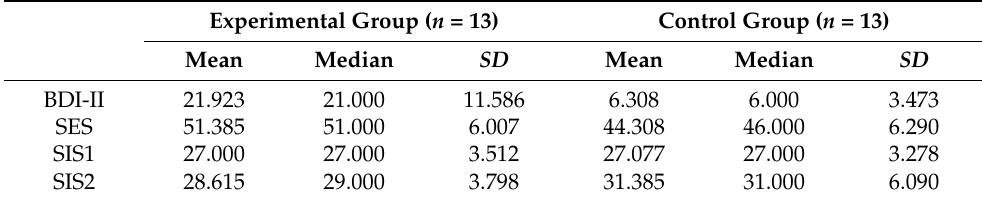
Table 3. Questionnaires: Mean, Median, and SD